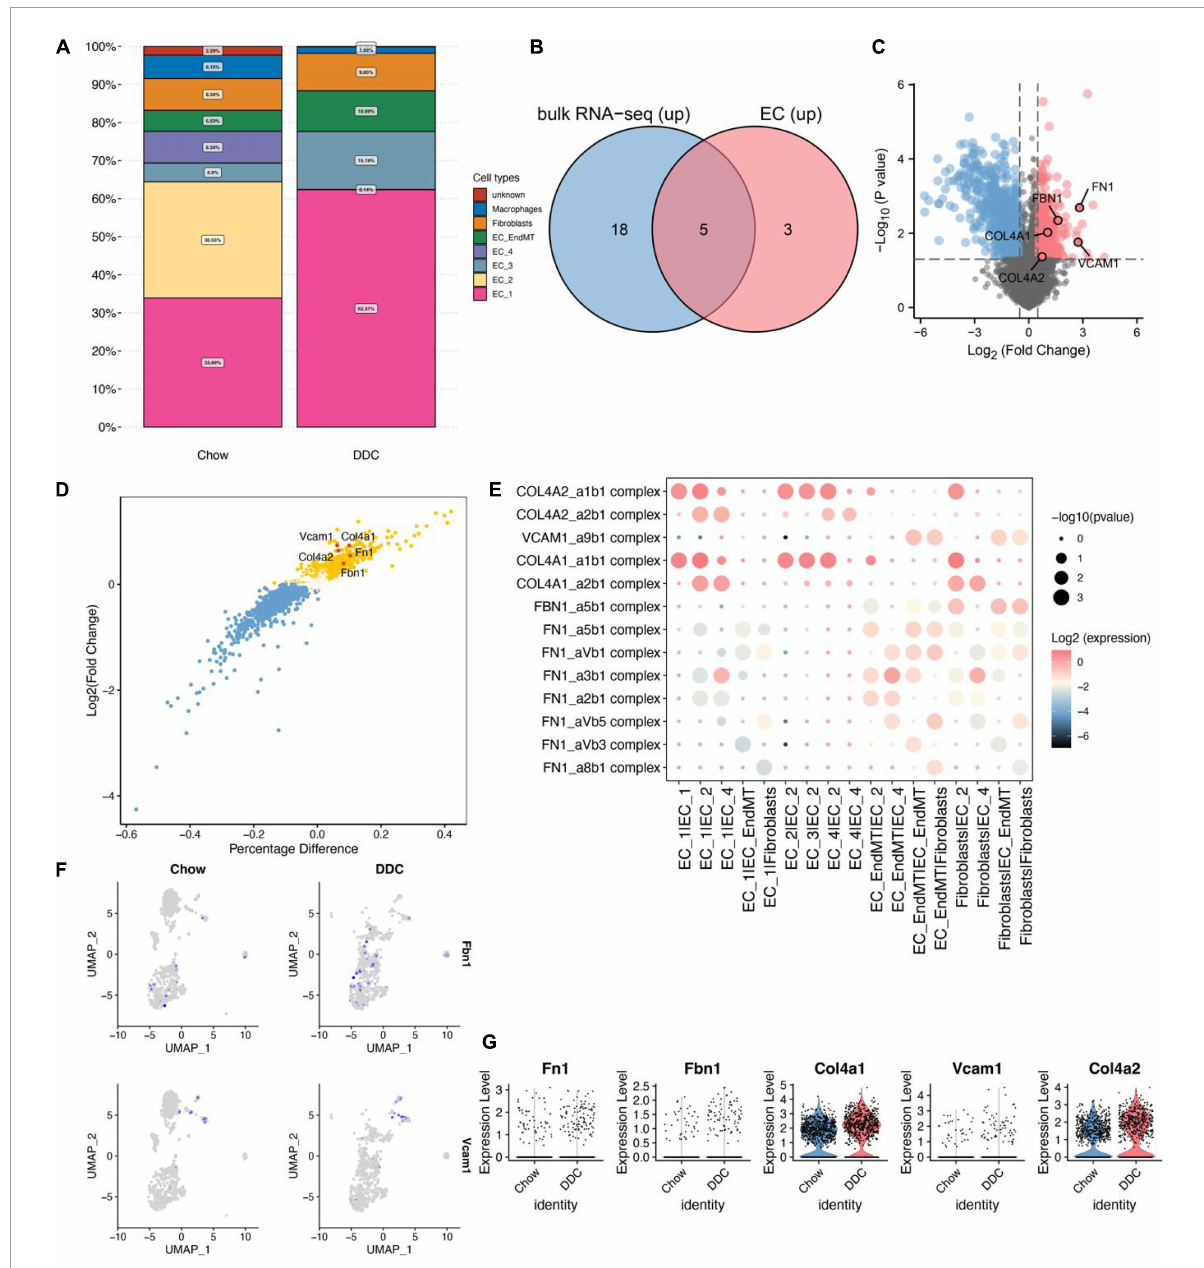
FIGURE2 Identification of up-regulated genes in the DM group based on cellular communication ligand-receptor analysis. (A) Proportions of each cell type in Chow and DDC groups. (B) Differential analysis based on bulk RNA-seq data and endothelial cell scRNA-seq data revealed that 23/8 genes from predicted ligand-receptor pairs were upregulated in the DM group. Intersection analysis revealed five up-regulated important genes in the DM group. (C) Volcano plot showed the results of differential analysis of the five important genes ( FN1 , VCAM1 , FBN1 , COL4A1 , and COL4A2 ) based on bulk RNA-seq data. (D) The results showed differential analysis of the 5 important genes based on scRNA-seq data from endothelial cells. (E) Dot plots showed that ligand-receptor pairs contain the five important genes in cell receptor-ligand interaction analysis and corresponding pairs of interacting cell types. (F) UMAP plots showed the expressions of Fbn1 and Vcam1 in endothelial cells. (G) Violin plots showed the expressions of the 5 important genes between the Chow and DDC